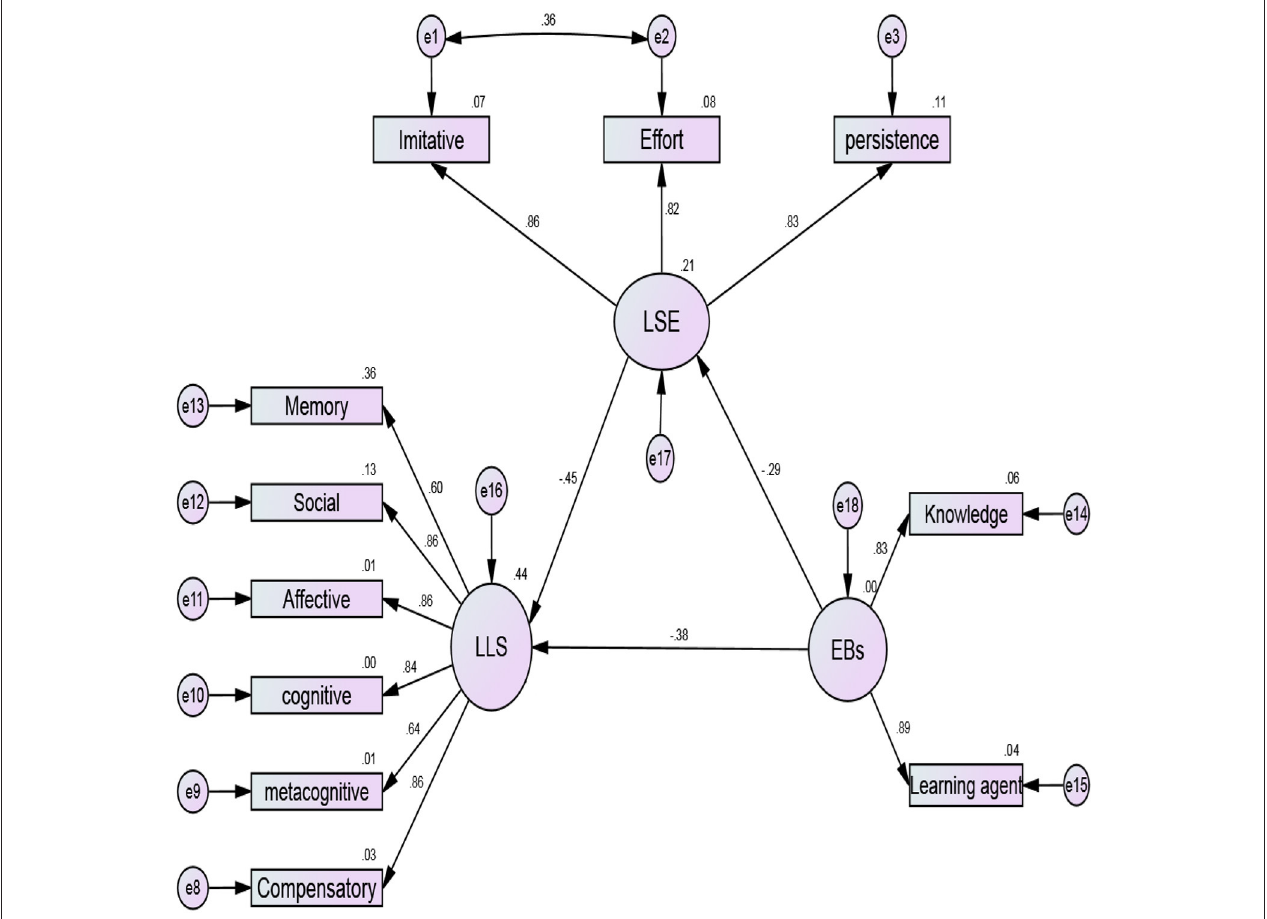
FIGURE 5 | Standardized tested model and interrelationships among the EBs, LSE, and LLSs.